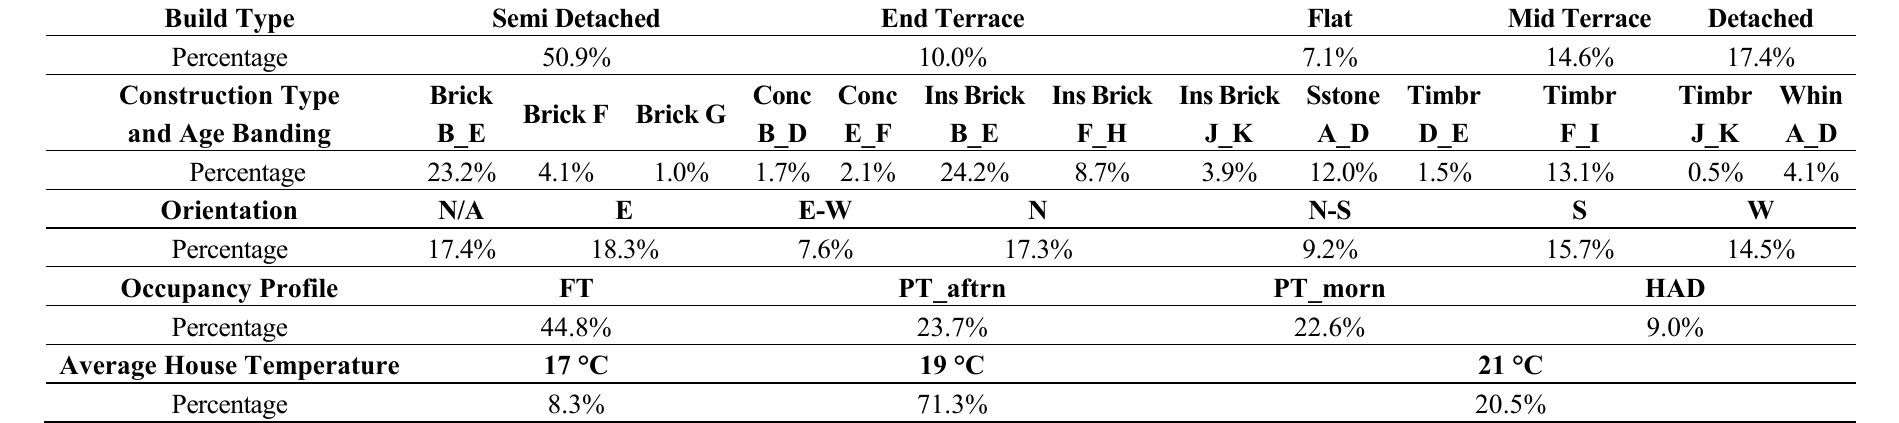
Table 1. Overview of building and occupancy types used to construct the aggregated thermal demand profile of Figure